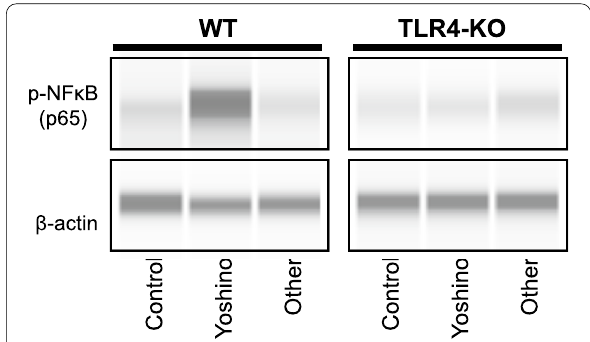
Fig. 5 Yoshino cedar stimulatled MEF cells on the LPS–TLR4 pathway. Protein levels of phosphorylated nuclear factor‑kappa B (p‑NF‑κB) were tested by Western blotting using WES system. Each samples were standalized by